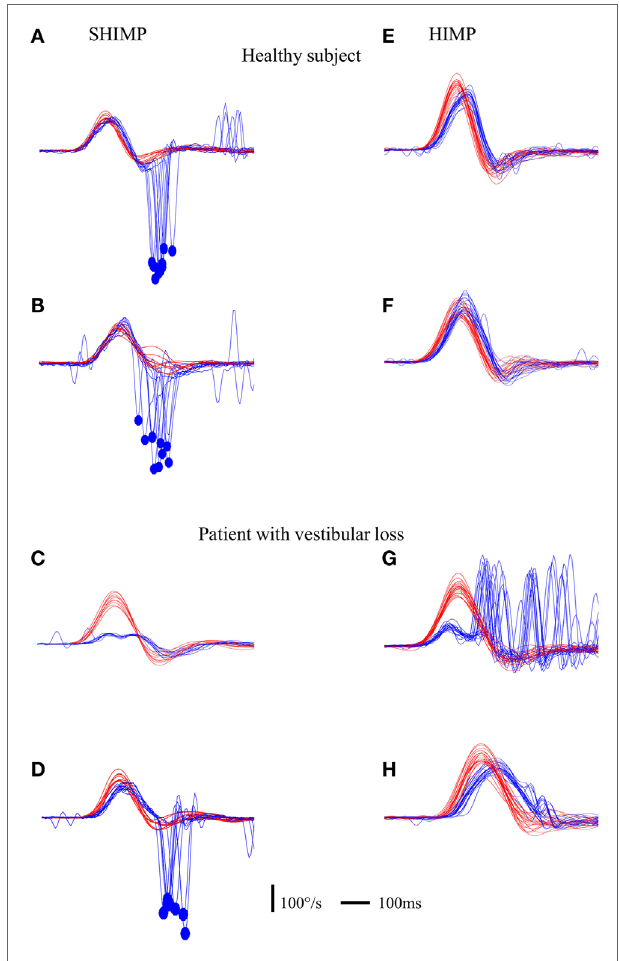
FigUre 2 | illustration of compensatory and anti-compensatory saccades obtained in shiMP and hiMP procedures, respectively . (a–D) SHIMP raw data in a normal subject when the head impulse was directed toward the left (a) and right (B) side and in a complete UVL patient when the head impulse was directed toward the right lesioned (c) and left intact (D) side. (e,F) HIMP raw data in a normal subject when the head impulse was directed toward the left (e) and right (F) side and in a complete UVL patient when the head impulse was directed toward the right lesioned (g) and left intact (h) side. Red curve: head velocity; blue curve: eye velocity; blue circle: peak saccade velocity; vertical bar: 100°/s; horizontal bar: 100